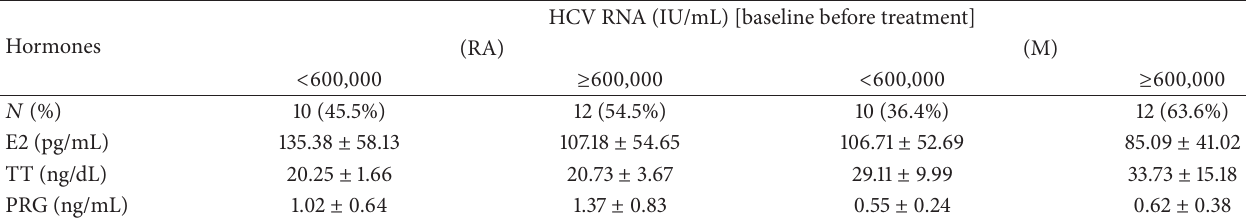
Table 4: The relation between viral load and hormonal levels in reproductive aged and menopausal patients. Hormones